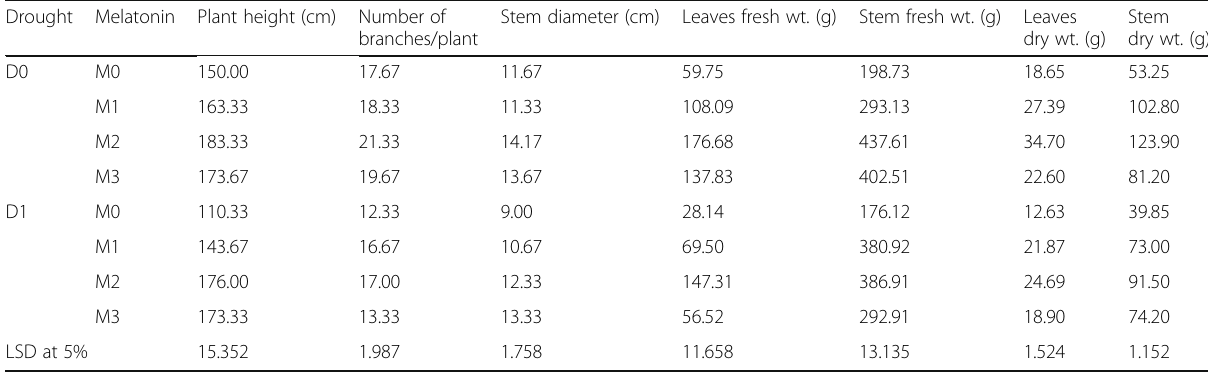
Table 3 Effect of melatonin (0, 50, 100, and 150 mM) on yield and yield components of M. oleifera plants subjected to drought stress (normal irrigation and skipping two irrigation times) (data are means of two